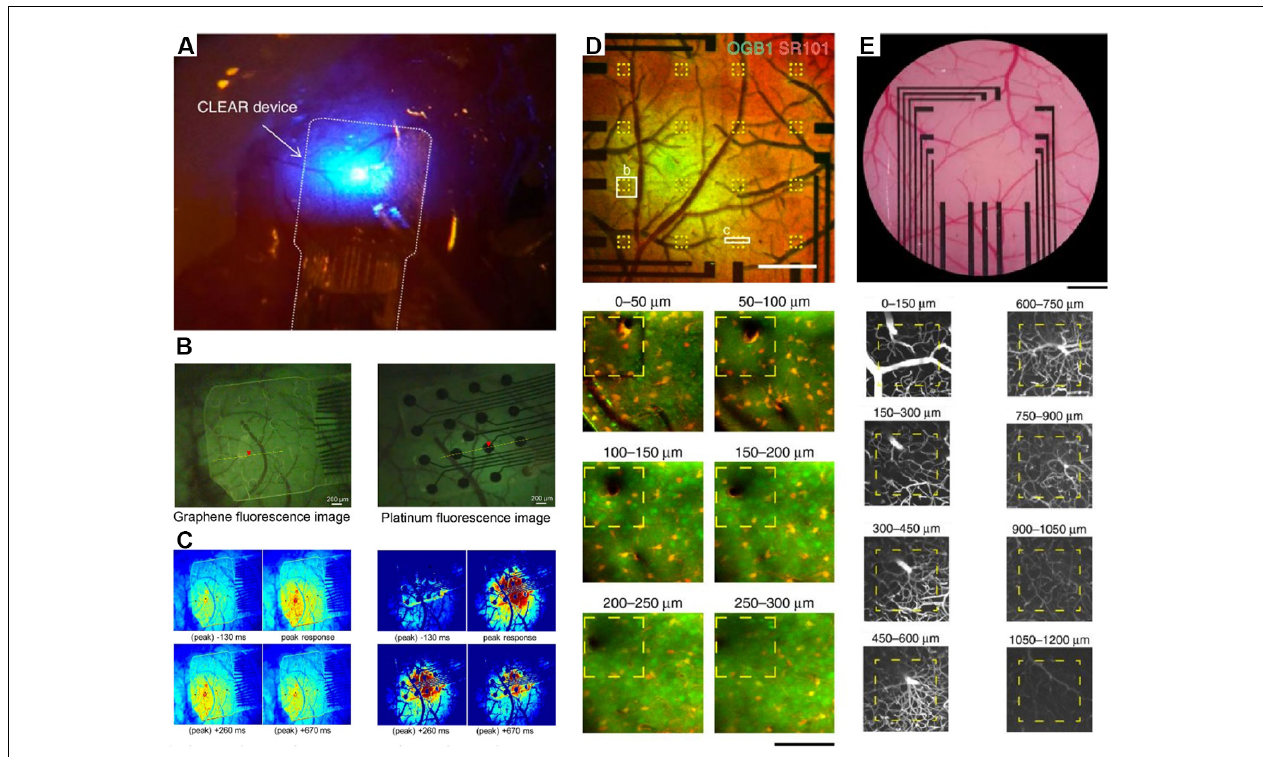
FIGURE 2 | Integration of transparent electrodes with complementary optical techniques in vivo . (A) Gr-based electrodes implanted on a mouse cerebral cortex. An optical fiber is also shown and used to deliver optogenetic stimulation. Modified with permission from Park et al. (2014). (B) Gr-based electrodes implanted on a mouse cerebral cortex (left) or traditional platinum electrodes Howe et al. (2013) and peak calcium responses from the same regions (C) . Panels (B,C) are from Park et al. (2018). Copyright ACS Publication. (D) Two-photon calcium imaging to a depth of 300 µ m through Gr-based electrodes and intravascular imaging (E) to a depth of 1,200 µ m. Modified with permission from Thunemann et al.